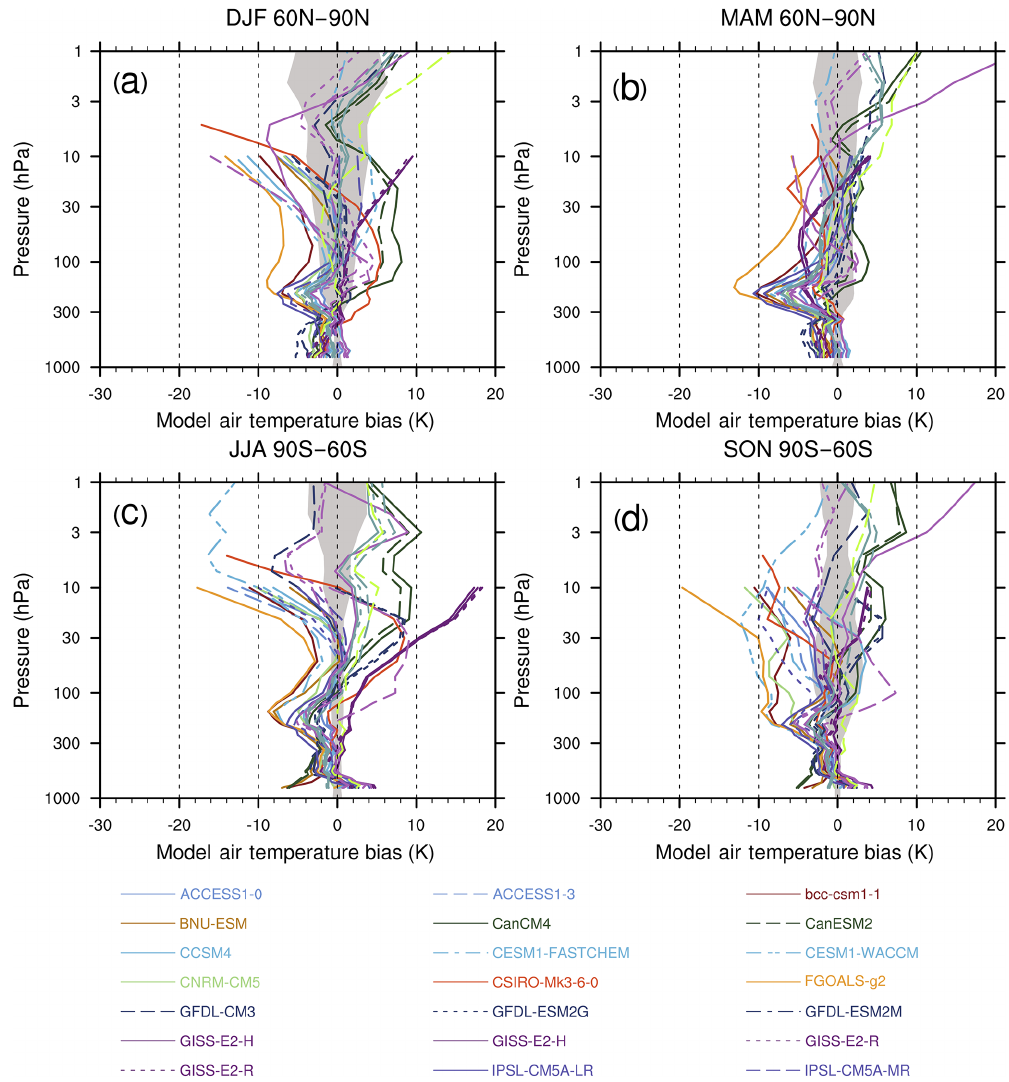
Figure 42. CCM climatological mean temperature biases for (a, b) 60–90 ◦ N and (c, d) 60–90 ◦ S for the (a, c) winter and (b, d) spring seasons for the period 1980 to 1999. Biases are calculated relative to ERA-40 reanalyses. The grey area shows ERA-40 plus and minus 1 standard deviation about the climatological mean. Similar to Fig. 1 of Eyring et al. (2006) and produced with the recipe_eyring06jgr.yml . See details in Sect.